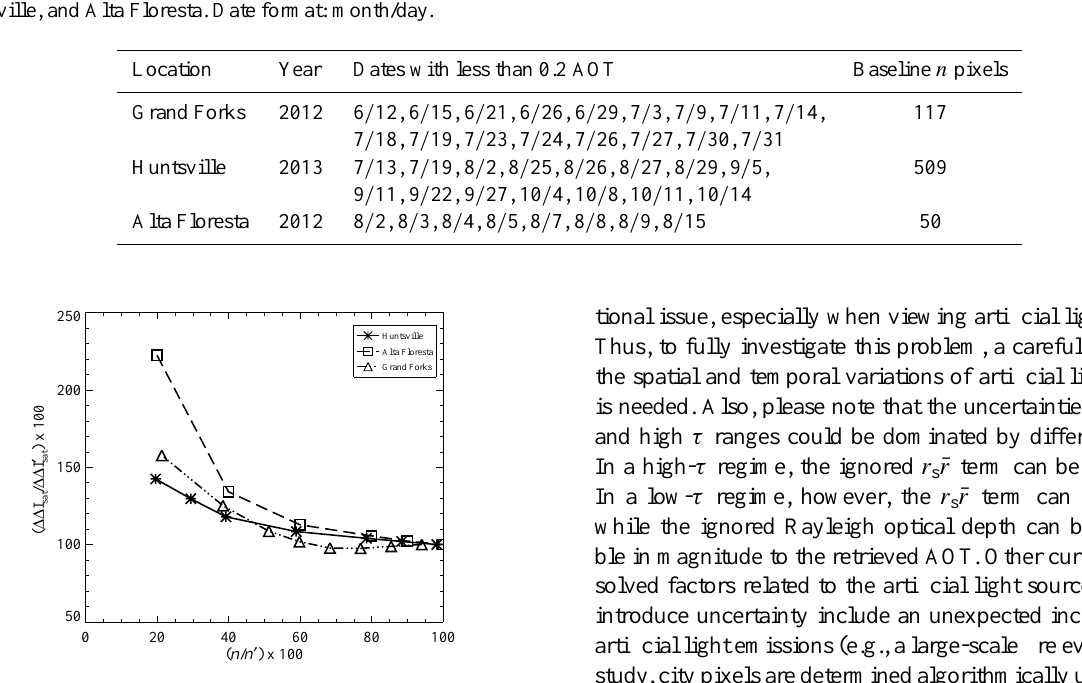
Figure 9. The normalized standard deviation of (cid:49)I sat values ( (cid:49)(cid:49)I sat ) as a function of the normalized number of brightest ar- tificial city light pixels ( n ) for selected nights that are relatively aerosol-free (HSRL and/or AERONET τ <0.2) for Huntsville, Alta Floresta, and Grand Forks. For a given location and for a given number of brightest artificial city light pixels taken from among the baseline case pixels, the standard deviations of (cid:49)I sat values are first computed using data from selected relatively aerosol-free nights. Both n and (cid:49)(cid:49)I sat value are then normalized based on the values used in the actual retrievals ( n (cid:48) , (cid:49)(cid:49) I sat (cid:48) ) as shown in Figs. 6 and 7 (details are listed in Table 4) for a comparison among different